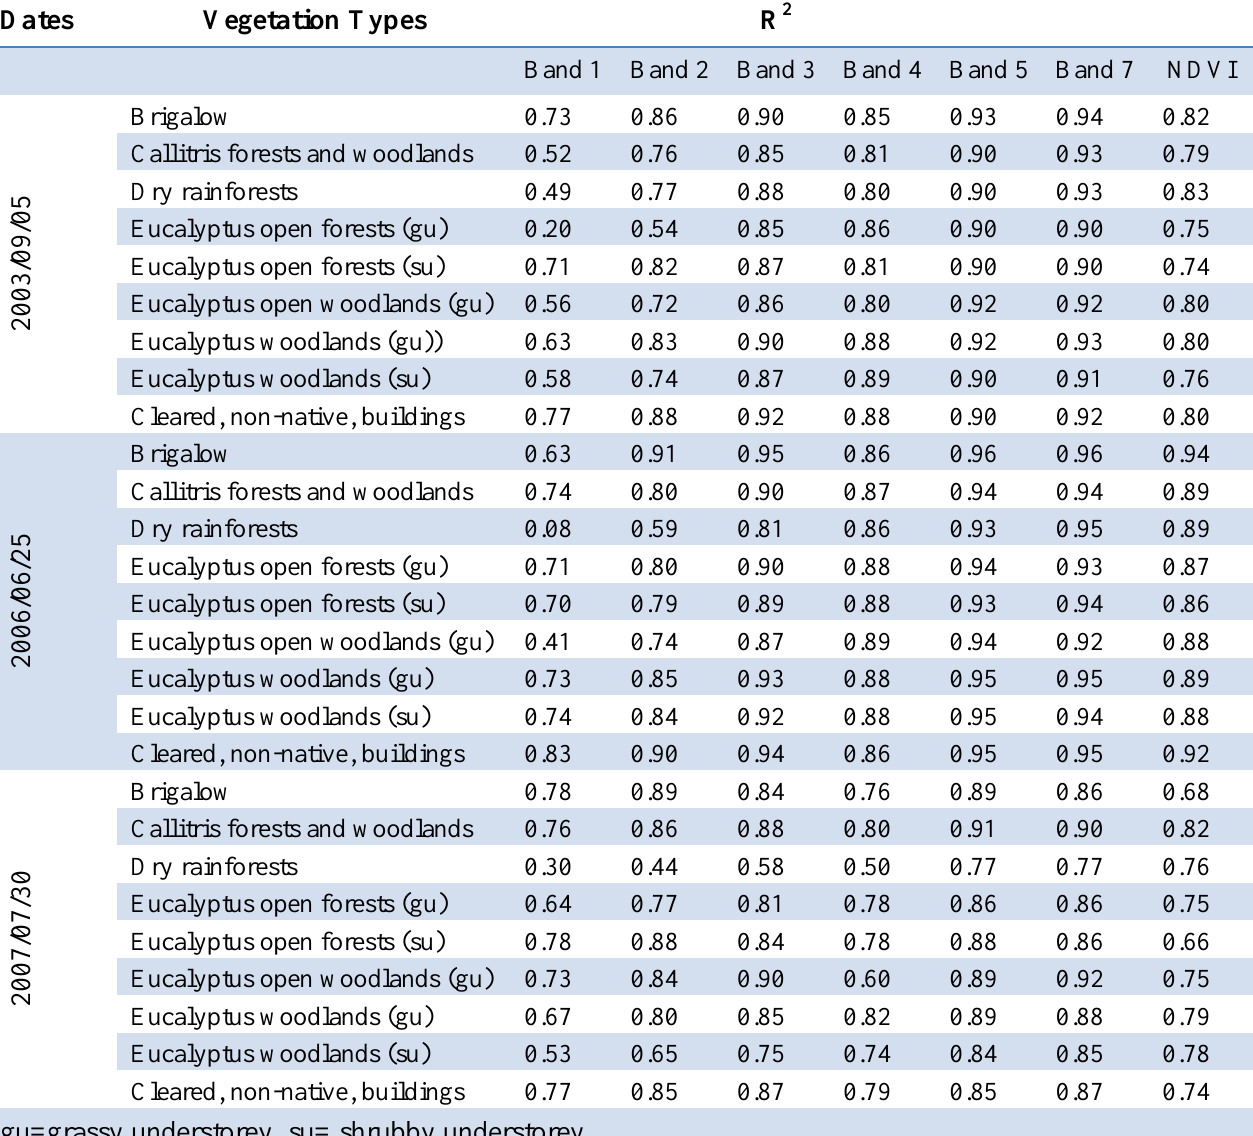
Table 4. Pixel based regression between reflectance values of the predicted Landsat TM scenes versus original Landsat TM scenes for three different dates for different forest communities in the Barakula State